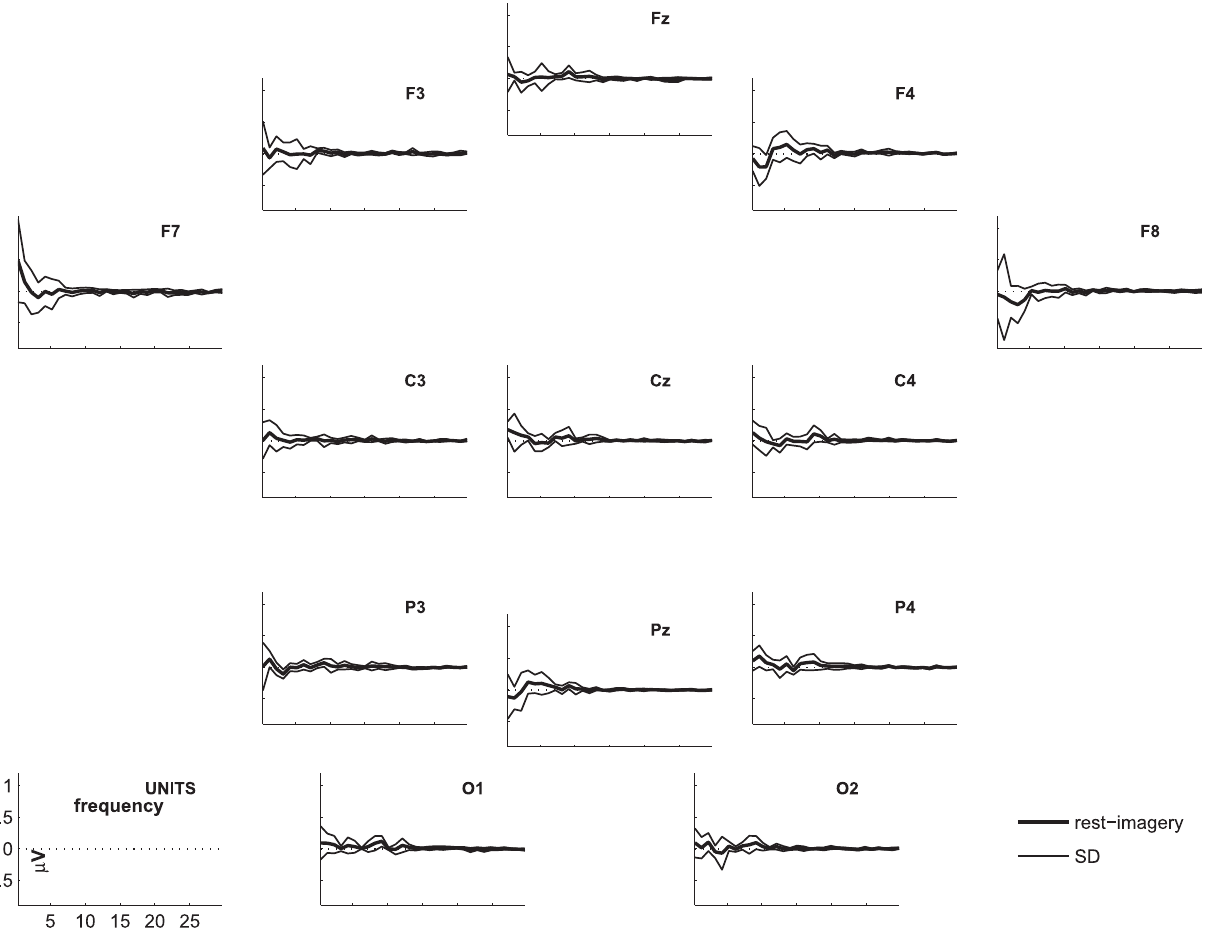
Figure 3. Differences in power spectra (rest-imagery) in patients in MCS. Thick line indicates the mean of the sample, the thin lines indicate the standard deviation.